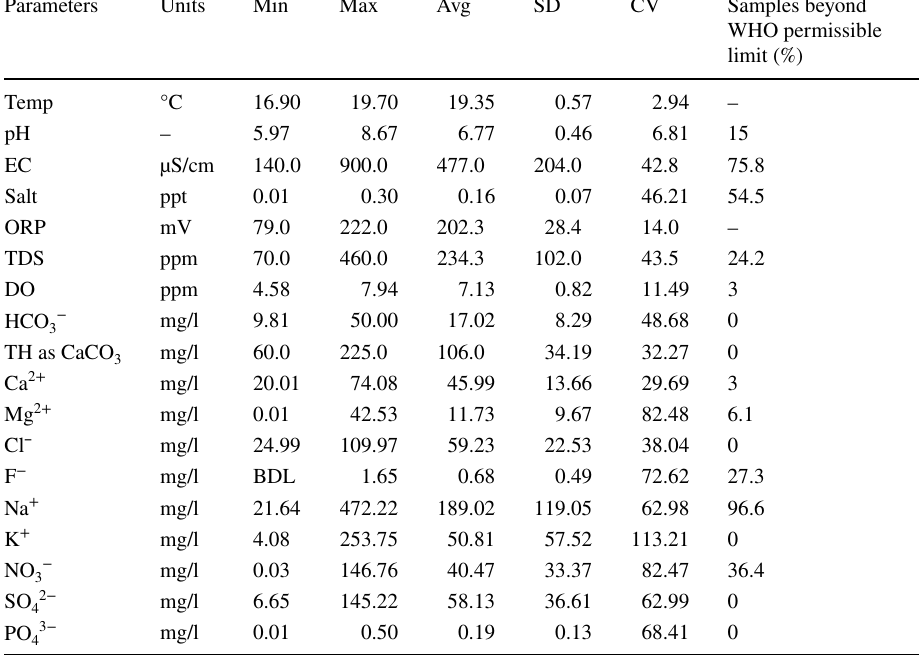
BDL below detection limit (<